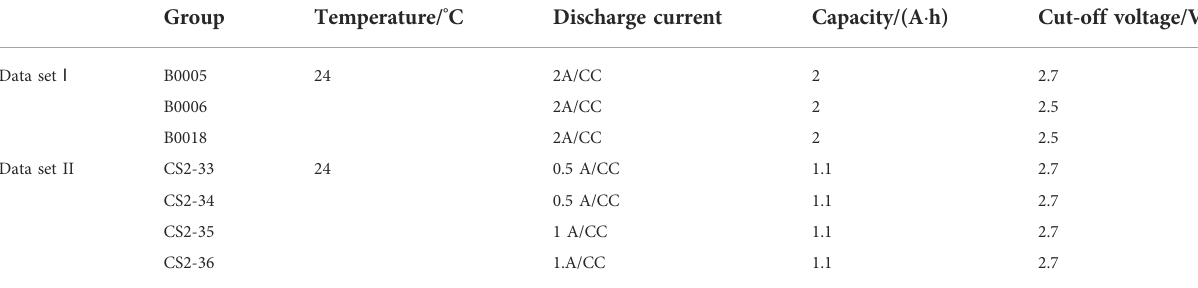
TABLE 2 Details of the experimental data